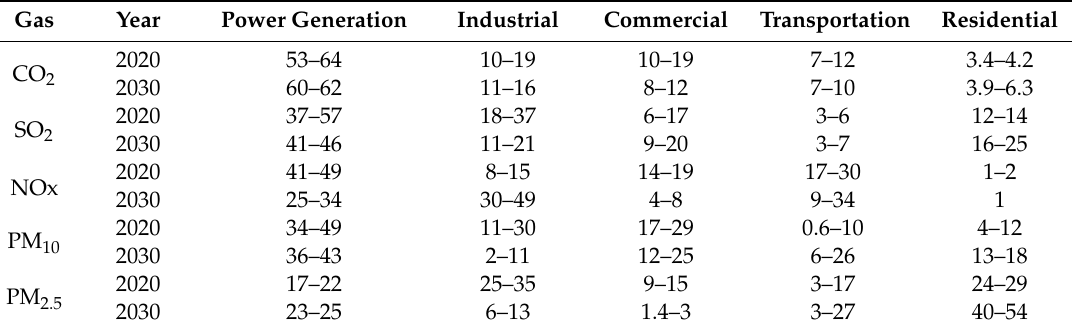
Table 7. The contribution rate of the energy-use sectors to emission reductions (unit: